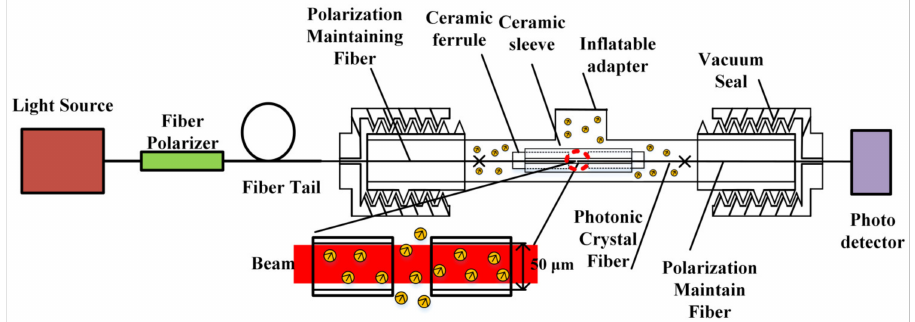
Figure 1. The schematic of the proposed fiber alkali vapor cell and setup. The fiber cables are sealed with the glass tube using vacuum screw caps. The sealing pipes with external thread are installed at both ends of glass tube through the mechanical structure. Keeping the optical fiber in the glass tube naturally straightened, the connection between the optical fiber and the sealing cap is sealed with vacuum sealant. Vacuum sealant should be completely dried after the subsequent